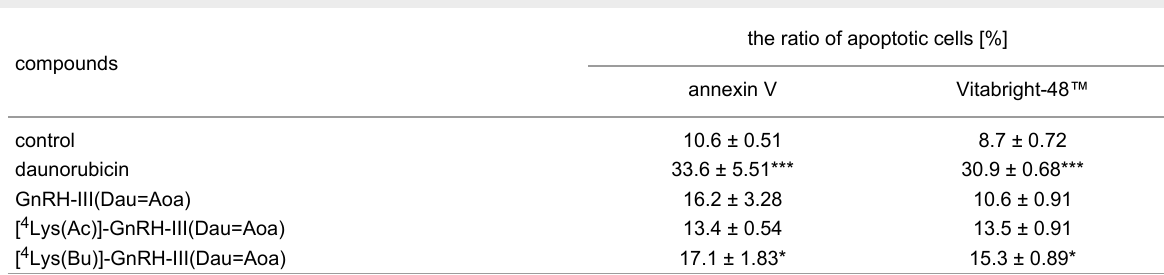
Table 4: Apoptosis inducer effects of the conjugates and daunorubicin (Dau) in melanoma cells.